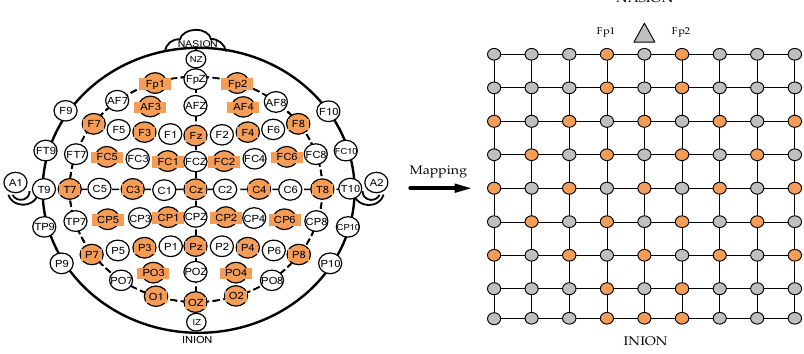
Figure 3. International 10–20 system and 9 × 9 square